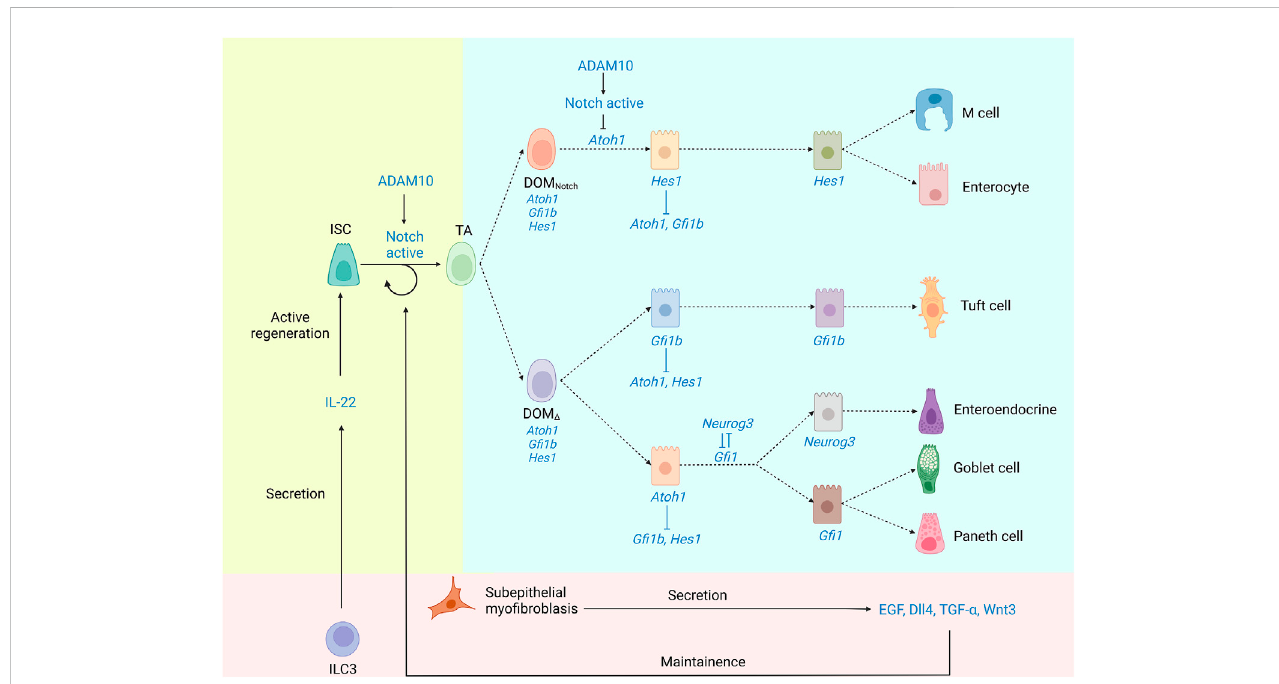
FIGURE 2 The underlying mechanism of IEC differentiation. Lgr5 + CBCs generate TA progenitor cells, which then differentiate into a spectrum of different absorptive and secretory cell lineages. Notch signaling is crucial to the maintenance of ISCs and the differentiation of TA. ADAM10, as an α -secretase, promotes Notch signaling. Atoh1 is necessary for stem cells to differentiate into secretory cells, while Hes1 acts to repress secretory cells. There is reciprocal repressionbetween Hes1 and Atoh1 . TCsareproduced fromG fi 1b-expressingprogenitors. Progenitorsdifferentiateintothreedistinctcellfatesthrough the guidance of three characteristic transcription factors, Hes1 , Atoh1 , and G fi 1b . Although TC is not Atoh1 -dependent, TCs are hypothesized to derive from secretory